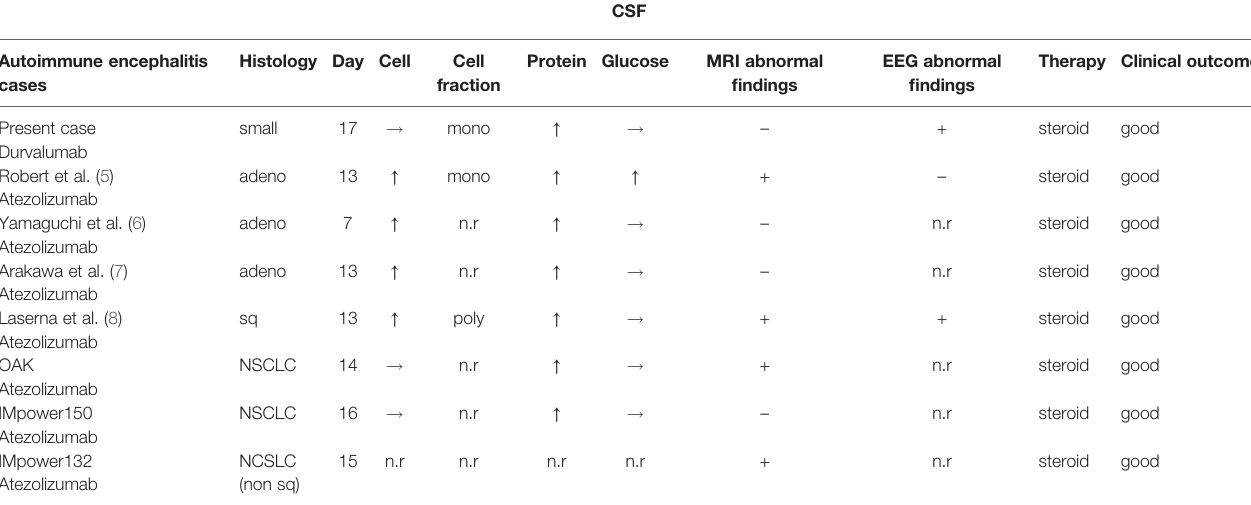
TABLE 1 | Characteristics of patients with autoimmune encephalitis associated with anti PD-L1 antibodies, including the present case, four cases from a case report, and cases of Japanese patients who participated in the OAK, IMpower150, and IMpower132 trials based on the appropriate use of atezolizumab from CHUGAI PHARMACEUTICAL CO.,